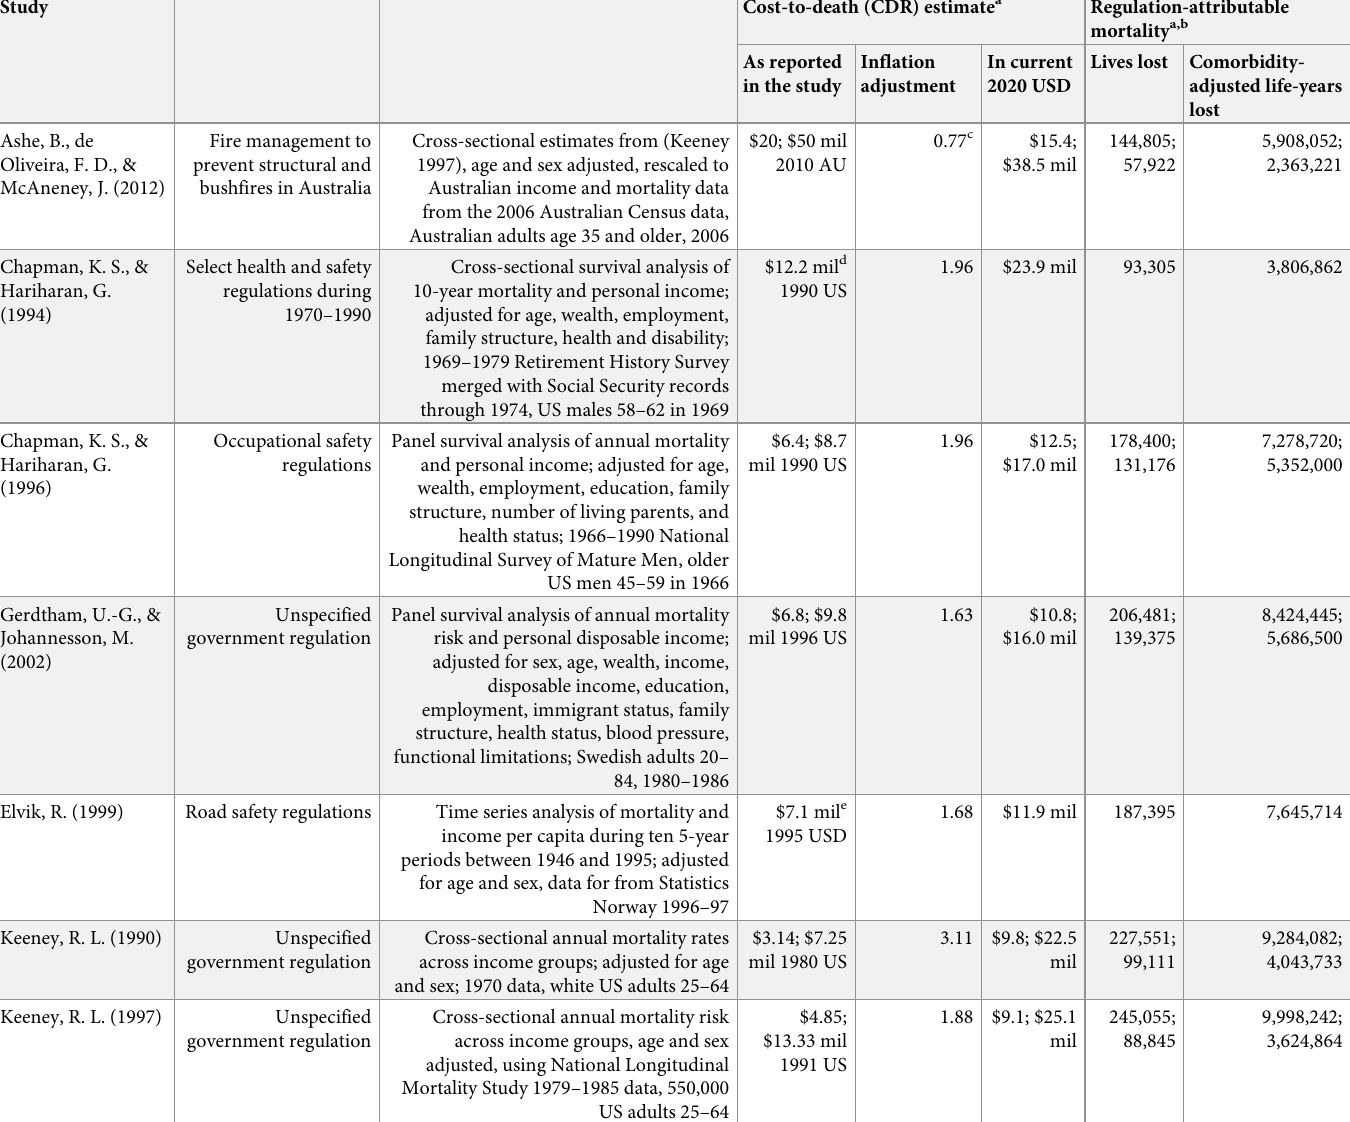
Table 1. Evidence table and regulation-attributable mortality calculations.